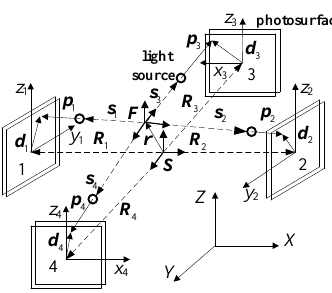
Figure 3. Diagram of a three-dimensional position measurement.